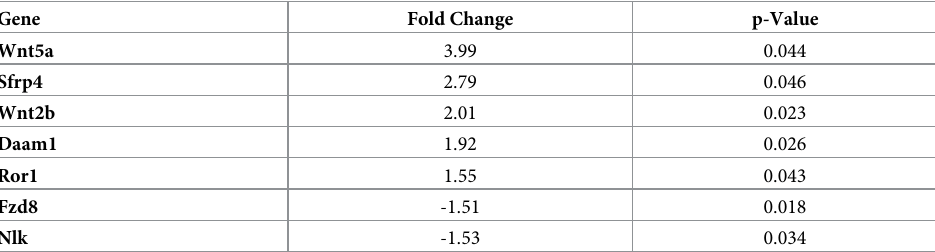
Table 2. Wnt pathway genes are differentially expressed in human